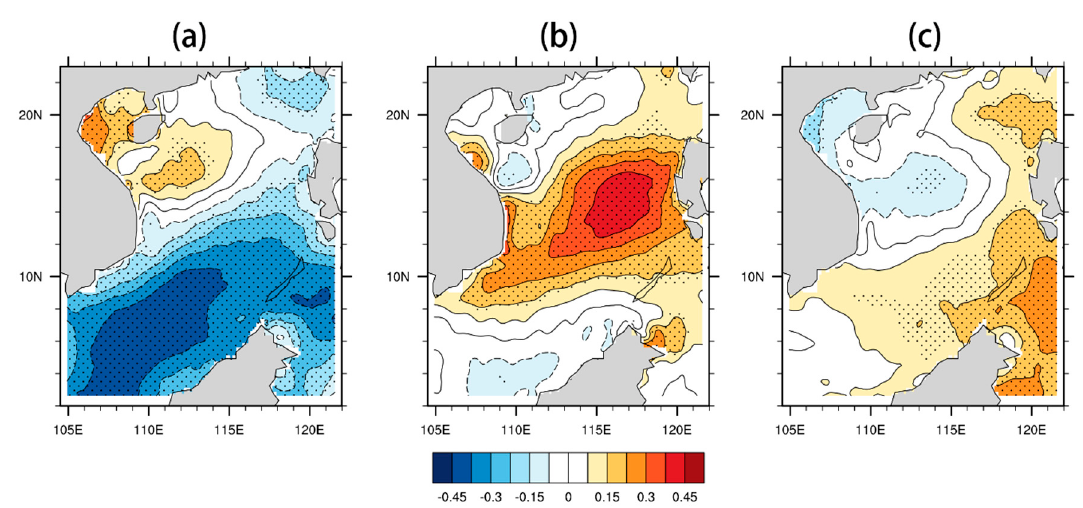
Figure 5. Correlation coefficients of BSISO-related anomalies of evaporation duct height over the SCS in summer. Figure 5( a – c ) correspond to the first/second/third EOF modes in Section 2. Dotted areas are statistically significant at the 99% confidence level based on a significant t-test.